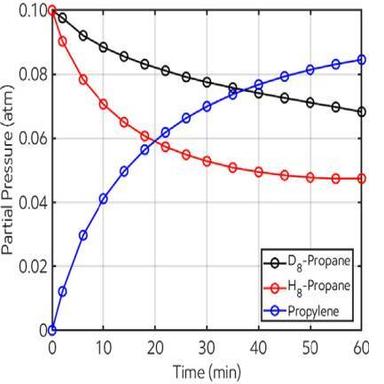
Reaction progress of reaction of 1:1 mixture of C3H8 (H8-propane) and C3D8 (D8-propane) on PtSn-12hr (black: D8-propane; red: H8-propane; blue: propylene). (For interpretation of the references to colour in this figure legend, the reader is referred to the web version of this article.)